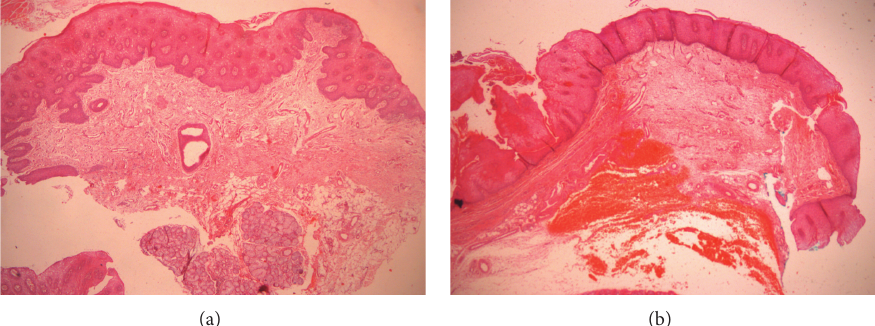
Figure 2: Histopathological aspects of previous biopsies with conventional technique showing epithelial tissue, connective tissue, and minor adjacent salivary glands, with no sign of tumor (H&E × 40) (a, b).